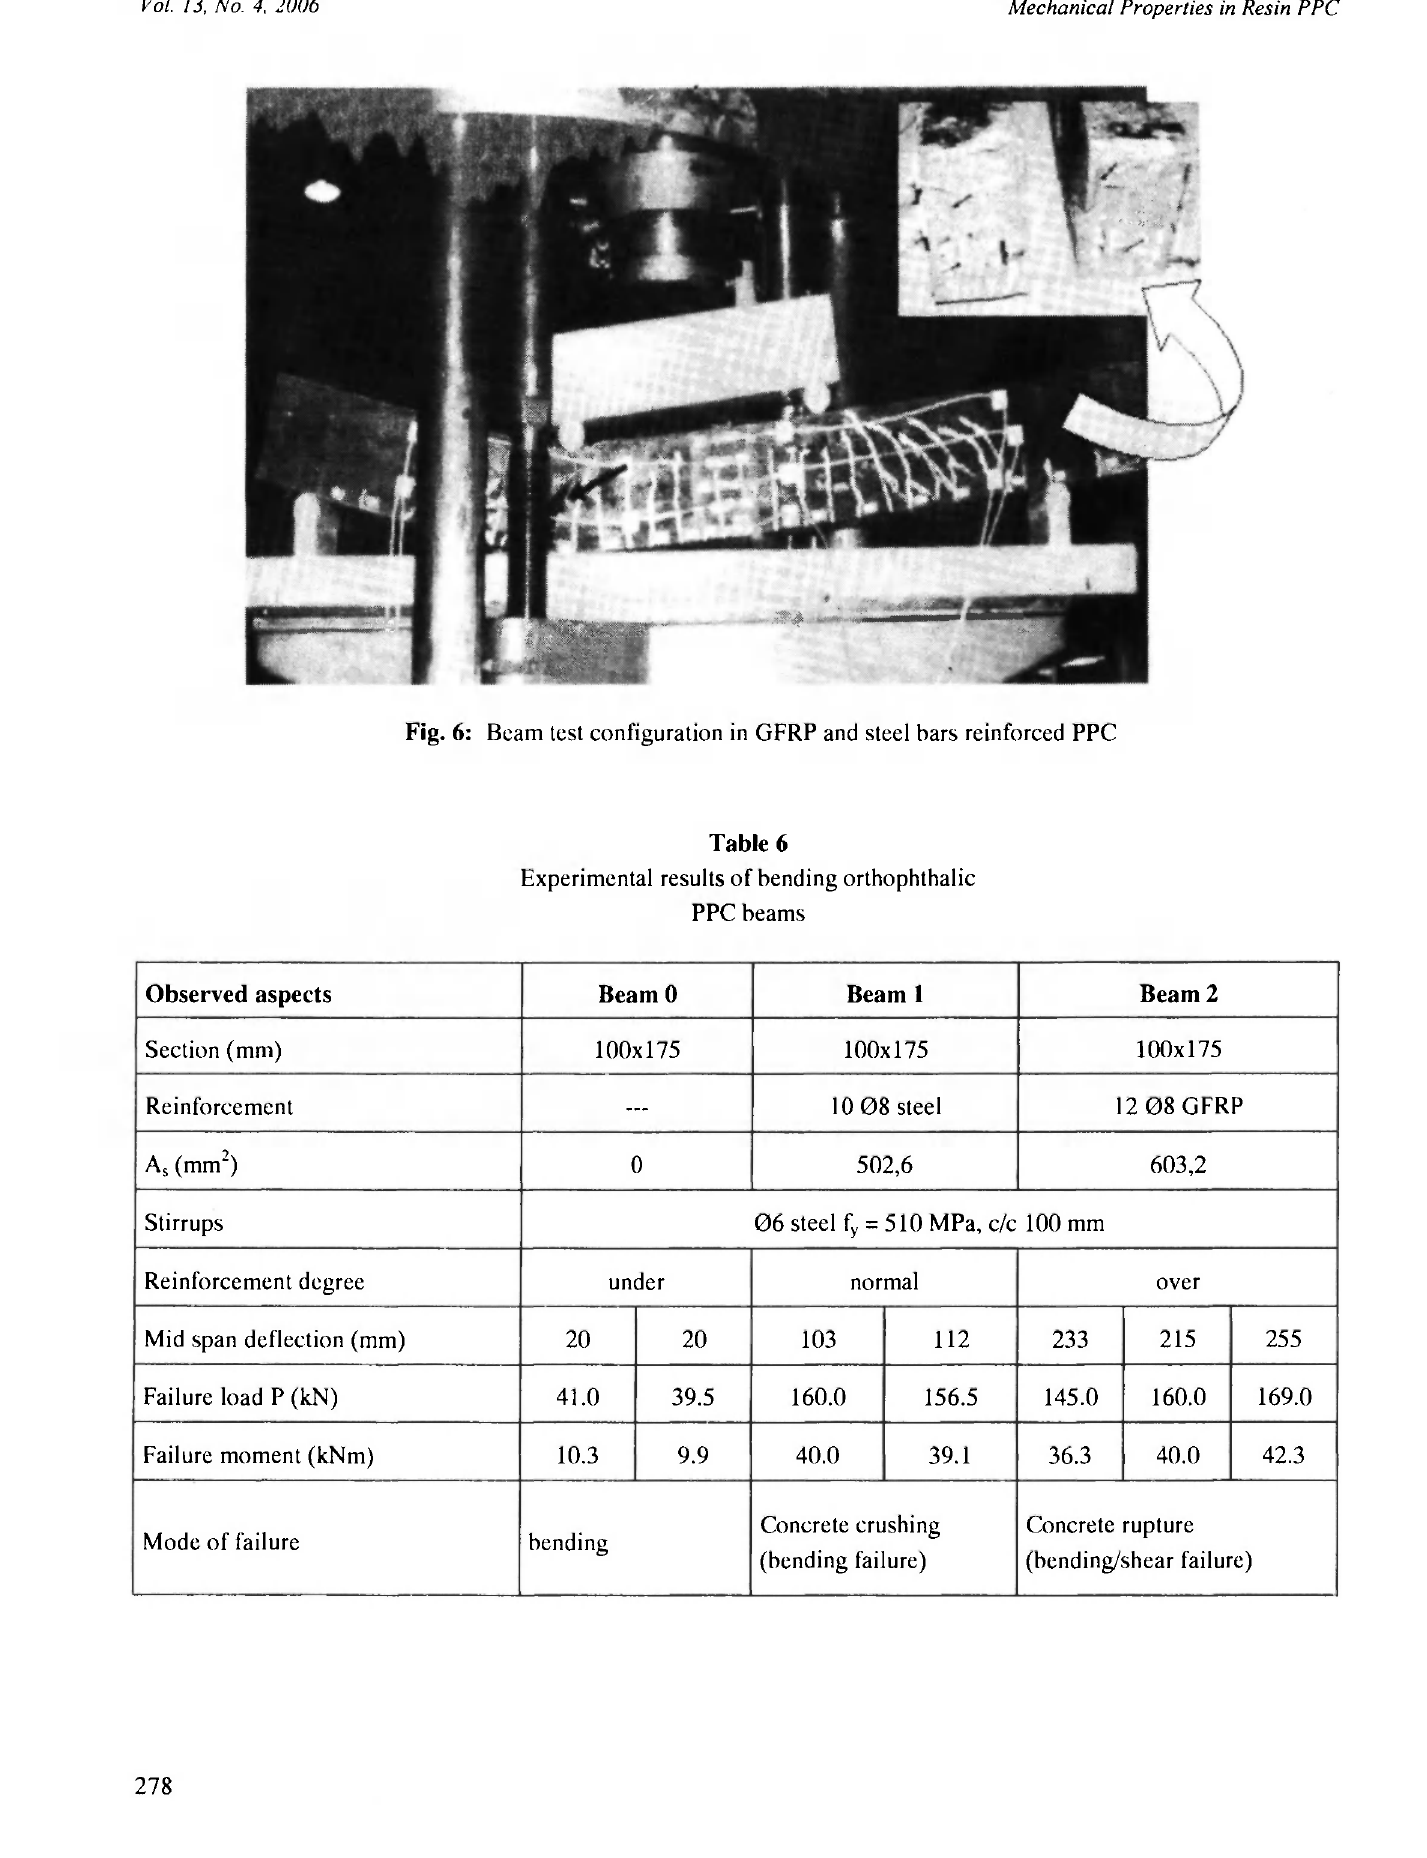
Fig. 6: Beam lest configuration in GFRP and steel bars reinforced